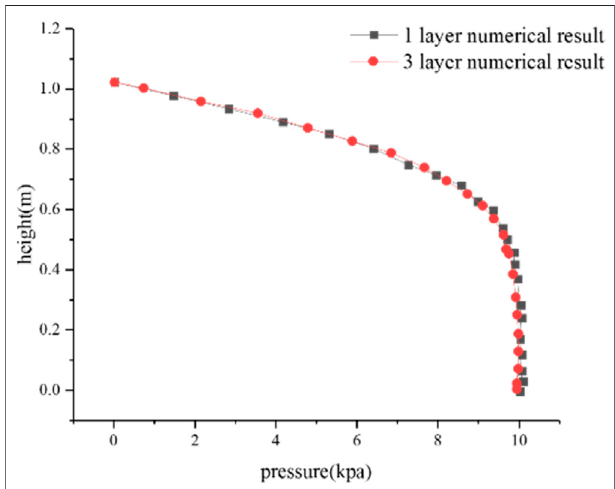
FIGURE 9 | Result of one homogeneous layer and three layers ’ consolidation before the stimulation reaches the second layer, overpressure distribution at 10